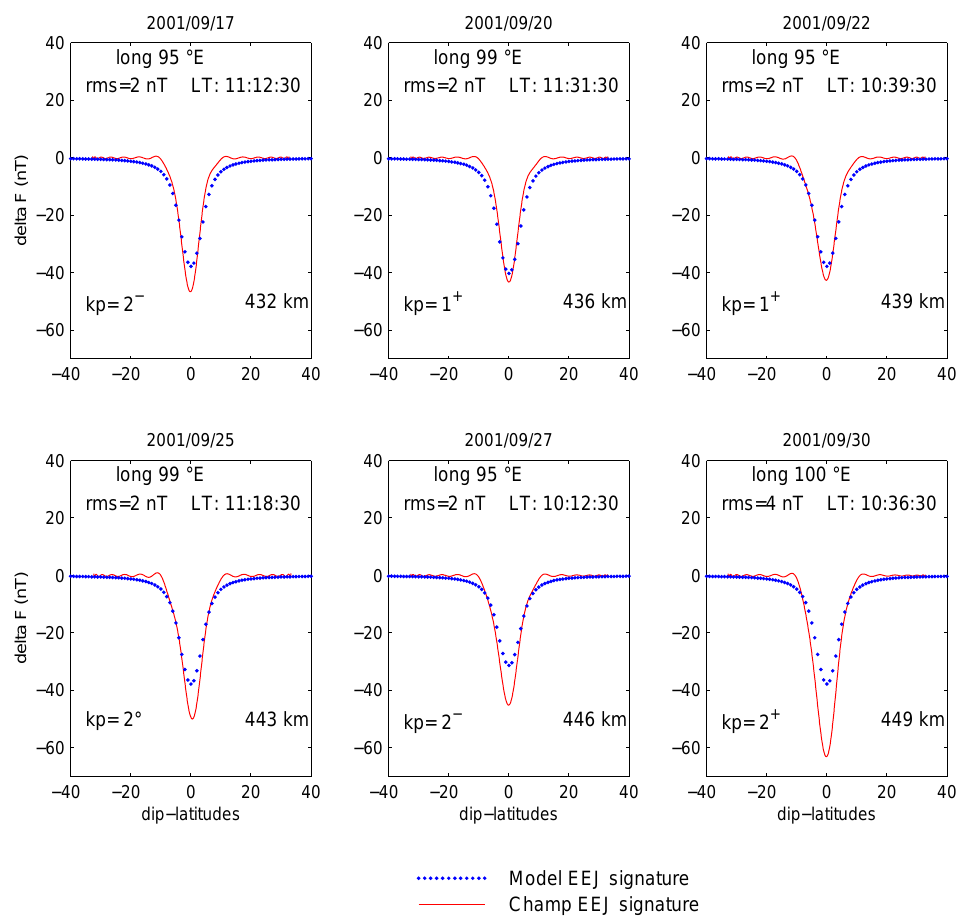
Fig. 7c. Comparison between the CHAMP satellite magnetic signature and the modeled magnetic effects of the EEJ. The modeled EEJ magnetic effects extrapolated at the altitude, longitude and local time of CHAMP satellite passes (blue dotted line) are compared with the observed EEJ signatures (red solid line) in the longitude band 15 ◦ W to 30 ◦ W. The modeled profiles were computed using the mean longitudinal profile of the EEJ magnetic signature. The altitude, longitude, local time and the rms are